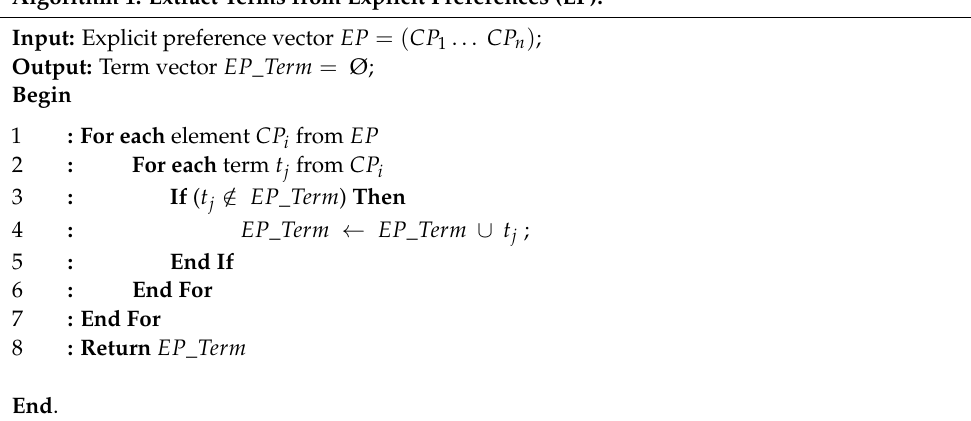
Algorithm 1: Extract Terms from Explicit Preferences (EP).